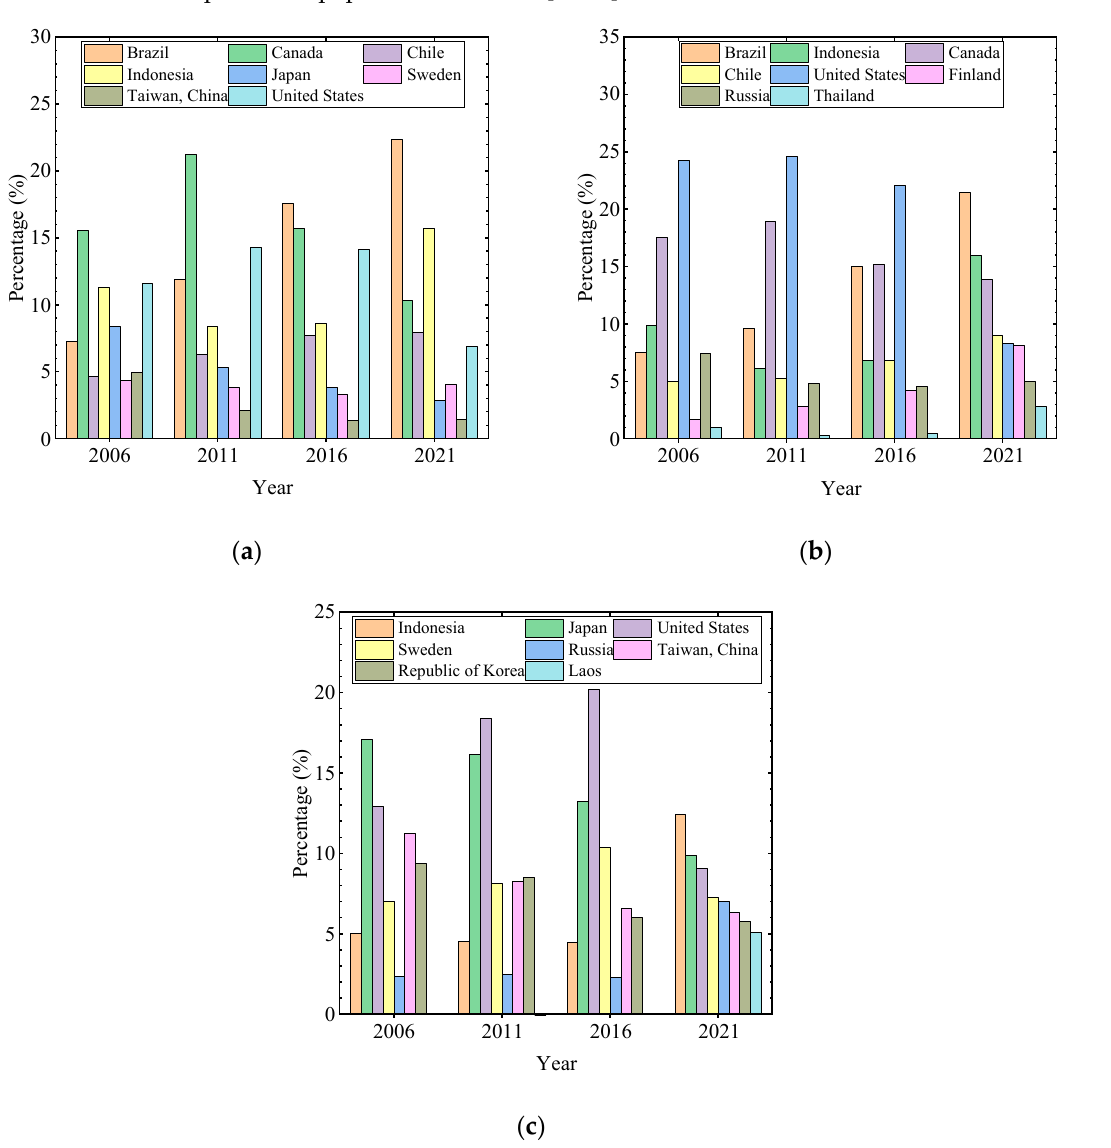
Figure 1. Percentage of China’s main import trading partners for pulp and paper products. ( a ) Pulp and paper products; ( b ) paper raw materials; ( c ) paper products.